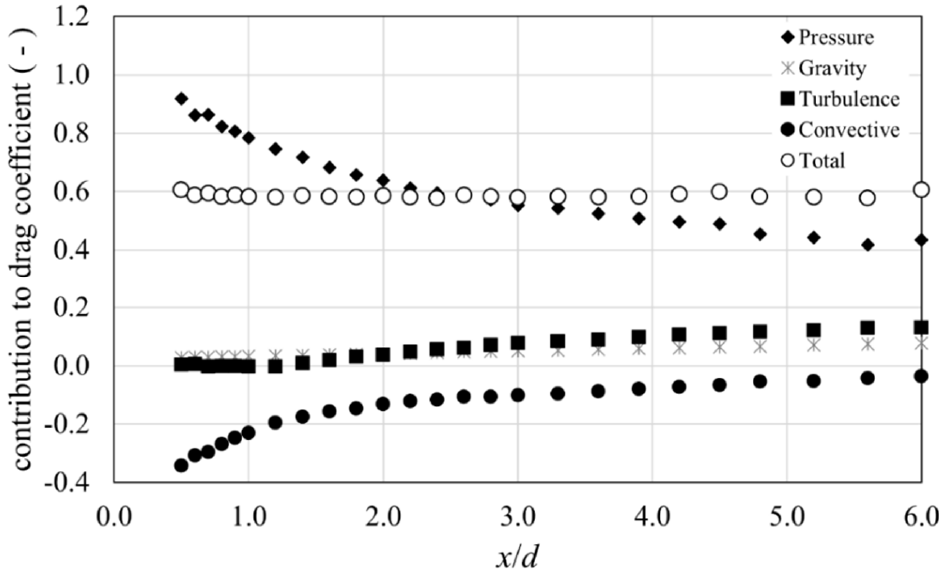
Figure 9. Net contributions to the drag coefficient for different positioning of the control section S 3 .